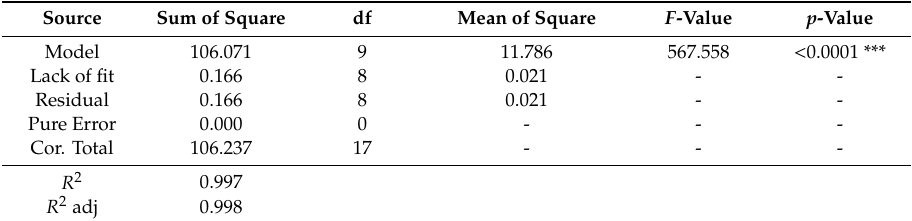
Table 4. ANOVA of the predicted model used for USAE of TPC from almond residues.